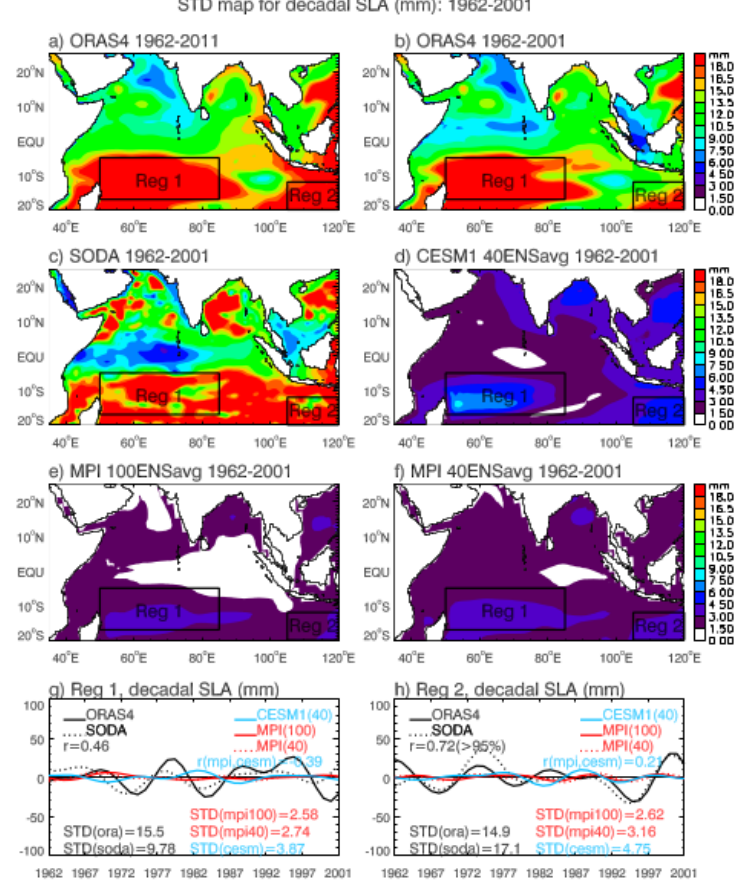
Figure 4. ( a ) The standard deviation (STD) map of decadal SLA (with global mean SLR and regional trend removed) from ORAS4 reanalysis over the tropical Indian Ocean for the 1962–2011 period. First, the global SLR was removed from the monthly sea level data for 1958–2015; then monthly climatology and the linear trend at each grid point were removed; finally, a Lanczos 8 year lowpass filter was applied; the first and last four years of data (1958–1961 and 2012–2015) are excluded to remove the endpoint effect of the filter; the two boxes show the maximum STD regions, with Reg. 1 representing the thermocline ridge (50 ◦ E–85 ◦ E, 17 ◦ S–5 ◦ S) shown in Figures 2 and 4, and Reg. 2, the near ITF region (105 ◦ E–120 ◦ E, 20 ◦ S–12 ◦ S); ( b ) same as (a) but for the ORAS4 for the 1962–2001 period; ( c ) same as (b) but for the SODA reanalysis data from 1962–2001; ( d ) same as (b) but for the CESM1 40-member ensemble mean from 1962–2001; ( e ) same as (d) but for the MPI 100-member ensemble mean from 1962–2001; ( f ) same as (e) but for the MPI 40-member ensemble mean; ( g ) the time series of decadal SLA averaged over Reg. 1; ( h ) same as (g) but for the decadal SLA averaged over Reg. 2. Units: